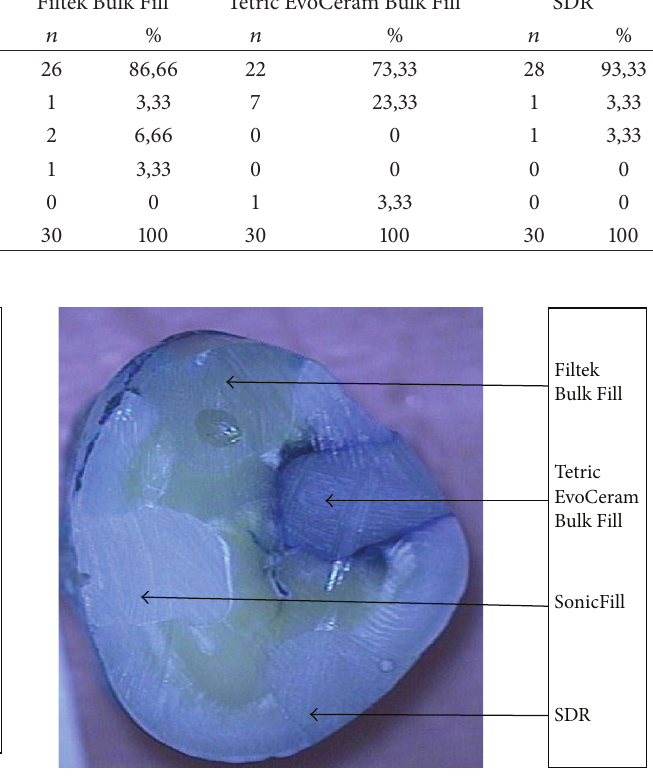
Figure 4: Discoloration of one of the restorations along the